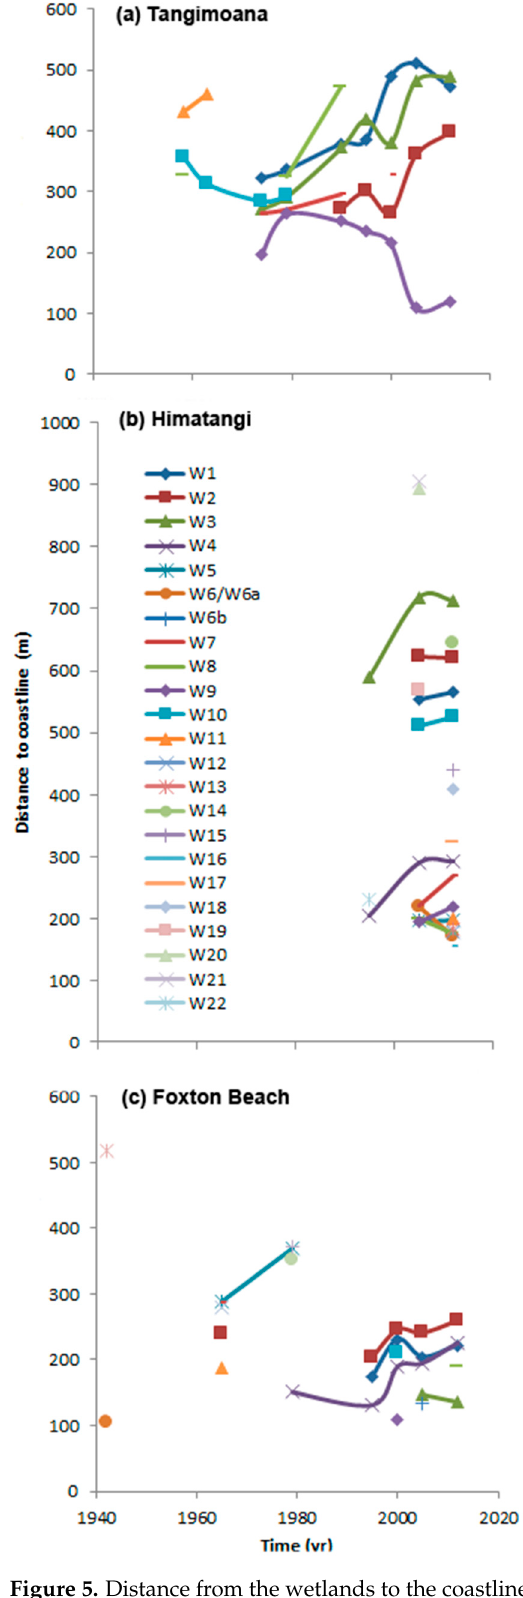
Figure 5. Distance from the wetlands to the coastline at the time of each image, by year at each of ( a ) Tangimoana, ( b ) Himatangi and ( c ) Foxton Beach. Symbols and colours as per key for each wetland (W) number, regardless of site. Lines are drawn to interpret, not to interpolate. At Tangimoana, wetlands 8 (1958) and 8a (1979–1990) are separate and distinct.